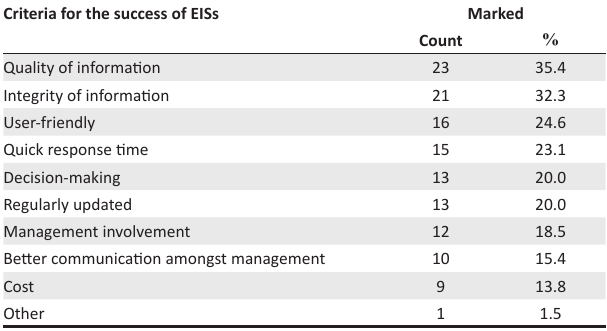
TABLE 7: Criteria for the success of Executive Information Systems (EISs). Criteria for the success of